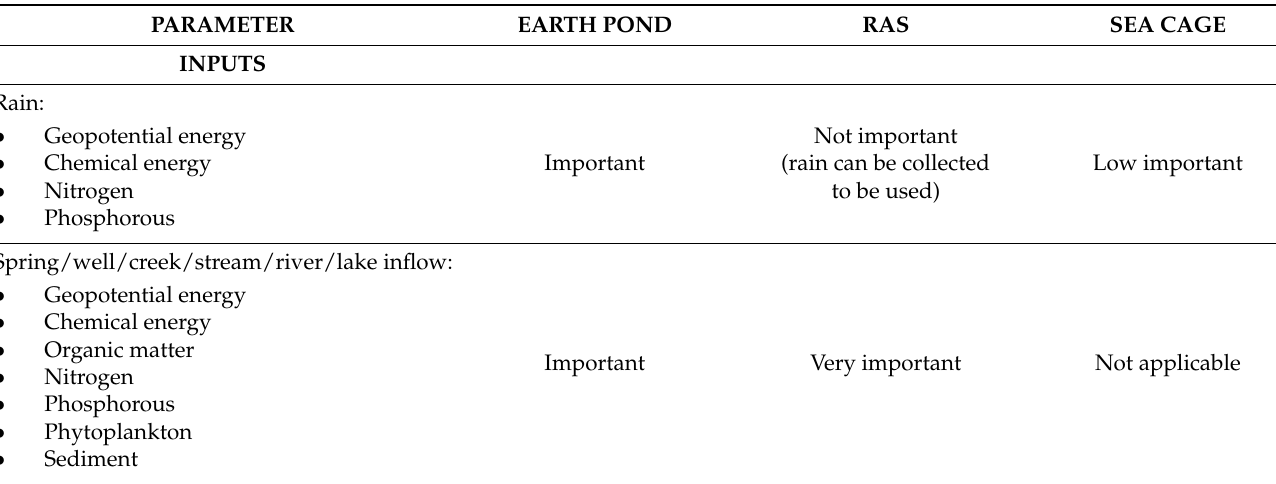
Table 5. Usual importance of water quantity/quality in aquaculture systems (earth pond, recirculating aquaculture system, and sea cage) to calculate water emergy